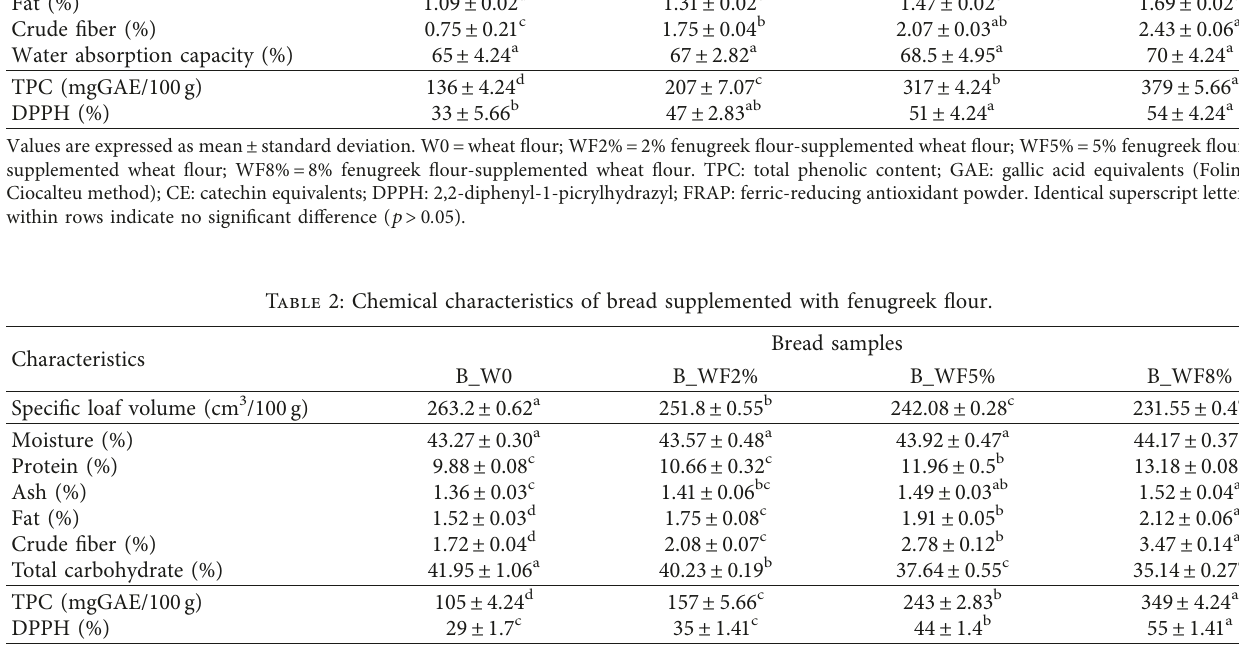
100% wheat (cid:30) 95% wheat flour+5% fenugreek flour; (cid:30)